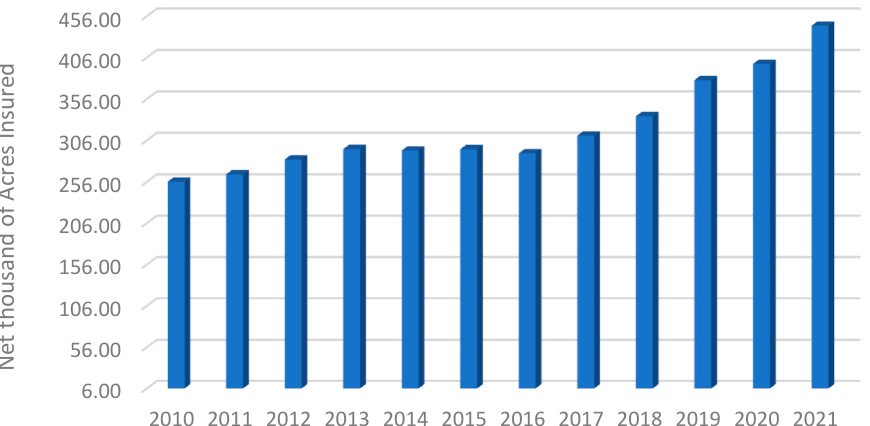
Figure 3. Net thousands of acres insured (source: United States Department of Agriculture [19]).